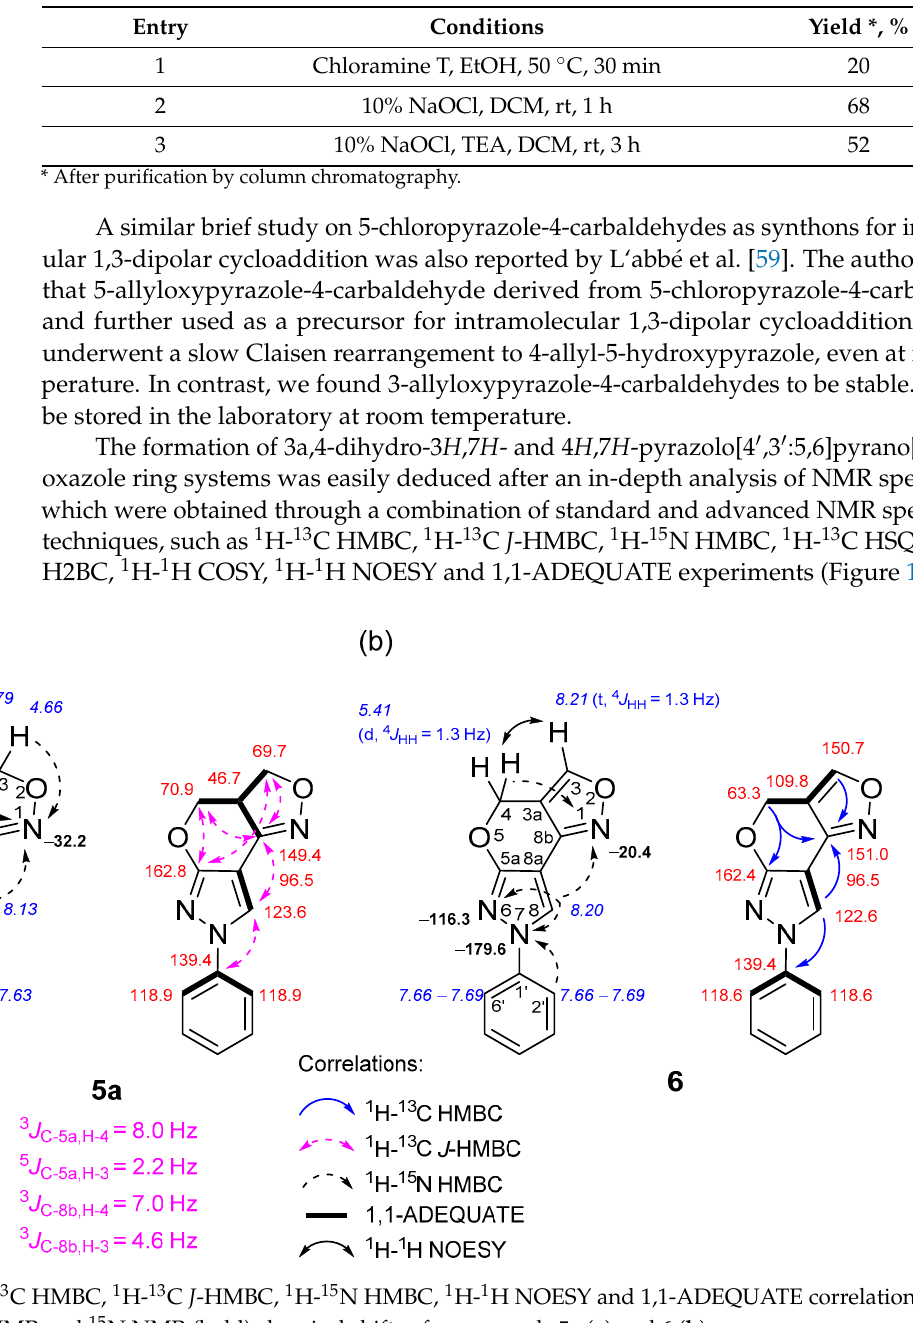
Table 1. Optimization of the INOC reaction conditions for 5a synthesis.